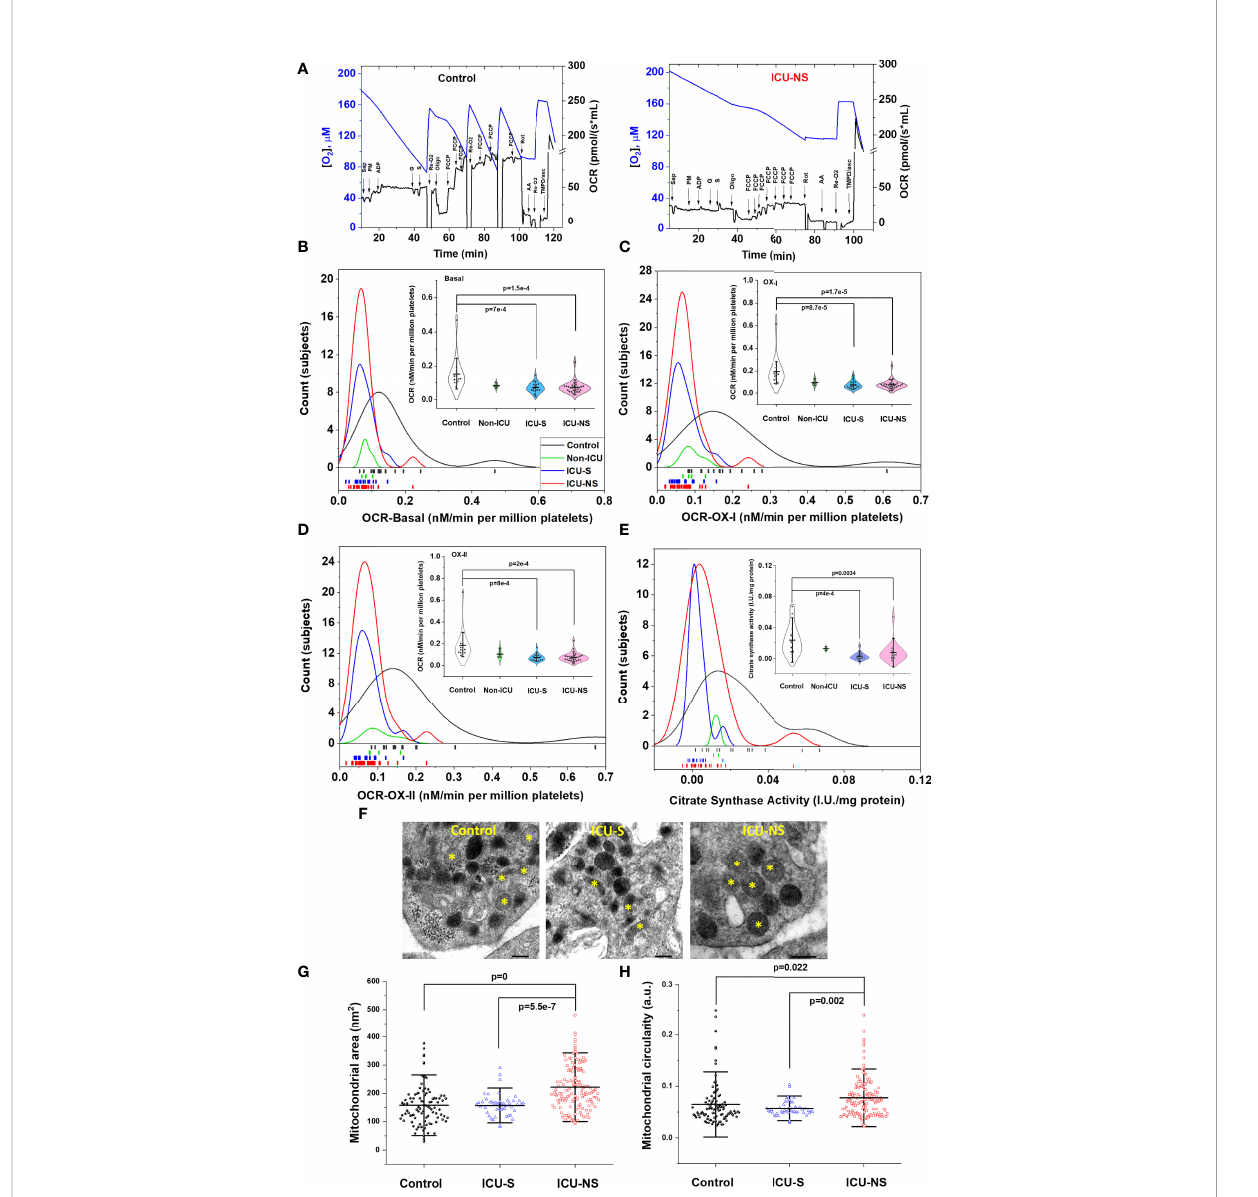
FIGURE 3 Depressed mitochondrial respiratory activity in severe COVID-19 patients. (A) Representative fi gures of the O 2 fl ux per volume measured by high-resolution OROBOROS O2k respirometer in permeabilized platelets for a control and an ICU-NS subjects. Distribution and rug plots showing reduction in mitochondrial respiration of ICU-hospitalized patients ’ platelets at basal (B) or upon Complex-I (C) or complex-II (D) stimulations. Violin plots within ( B – D ) showing a statistically signi fi cant decrease in the oxygen consumption rate at basal (B) or during Complex-I (C) or complex-II stimulations (D) in ICU-hospitalized patients relative to control group (n=15, 4, 17, and 29 for control, non-ICU, ICU-S, ICU-NS; respectively). (E) Citrate synthase activity in platelets was signi fi cantly decreased in ICU-hospitalized patients relative to control group (n=15, 2, 15, and 21 for control, non-ICU, ICU-S, ICU-NS; respectively). (F) Representative TEM images showing changes in mitochondria morphology in platelets of control and ICU-hospitalized patients. Additional images are given in Supplementary Figure S3. Quanti fi cation diagrams revealed signi fi cantly increased average cross-sectional area (G) and circularity (H) in platelets mitochondria from the ICU-NS group relative to control and ICU-S. groups (n=1-3 for each group and analyzed mitochondria n= 96, 48, 144 for control, ICU-S, ICU-NS; respectively). Multiple comparisons were carried out using ANOVA followed by Tukey test and p values are given. Data plotted as mean ± SD.* denotes identi fi ed